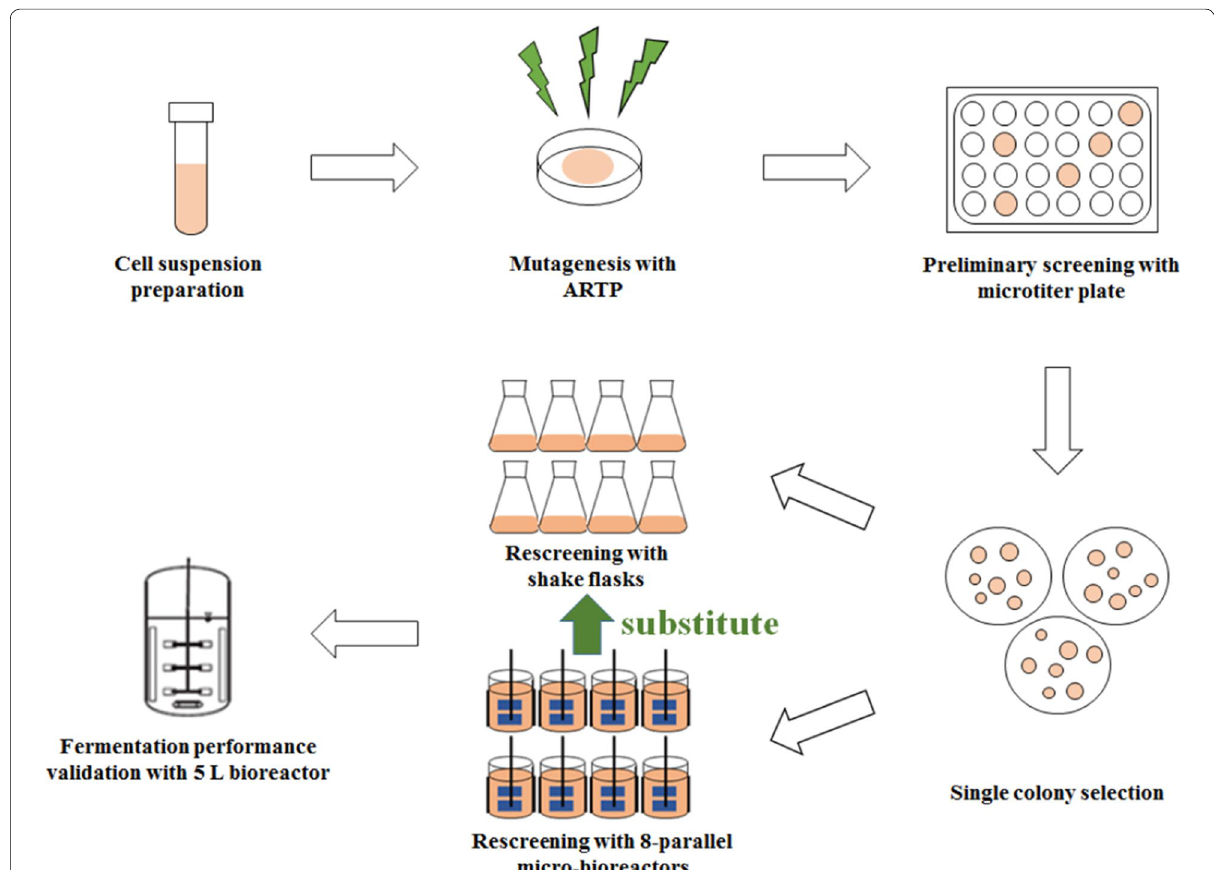
Fig. 2 The scheme followed in the high-throughput screening for the high lactic acid producing strain with shake flasks and